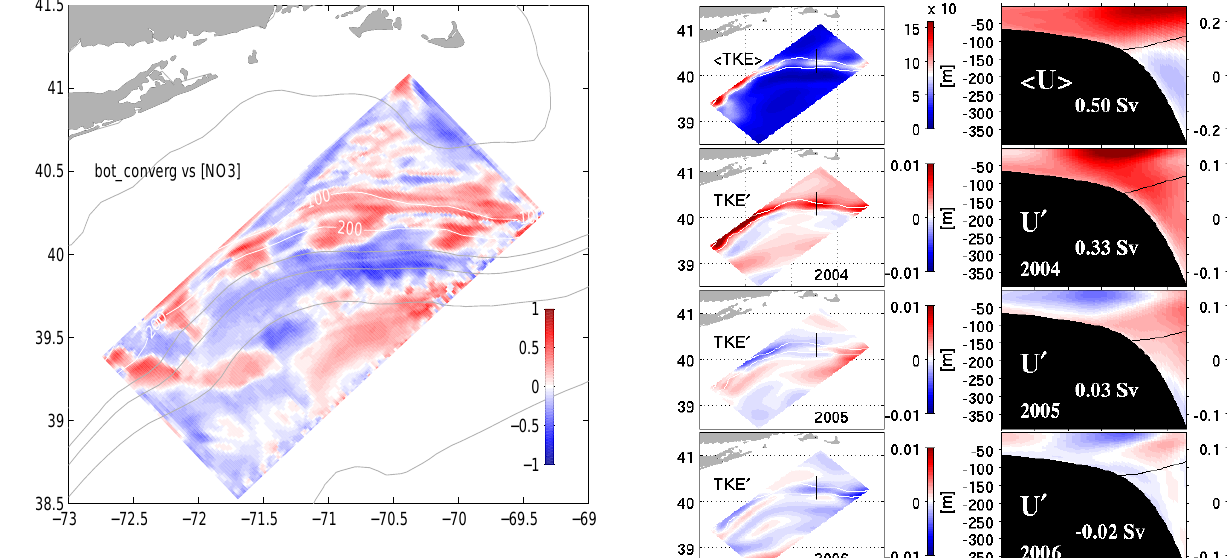
Figure 11. Spatial correlations between the bottom convergence and NO3 894 Fig. 11. Spatial correlations between the bottom convergence and concentration in the upper 50 m. Also shown are isobaths (gray curves) with 100 and 895 NO3 concentration in the upper 50m. Also shown are isobaths 200 m isobaths highlighted in white. 896 (gray curves) with 100 and 200m isobaths highlighted in white.